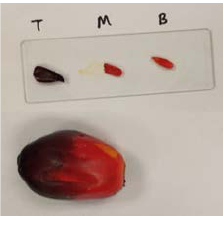
Figure 2. Thin film preparation from the fruit exocarp (T: top, M: middle, B: bottom).